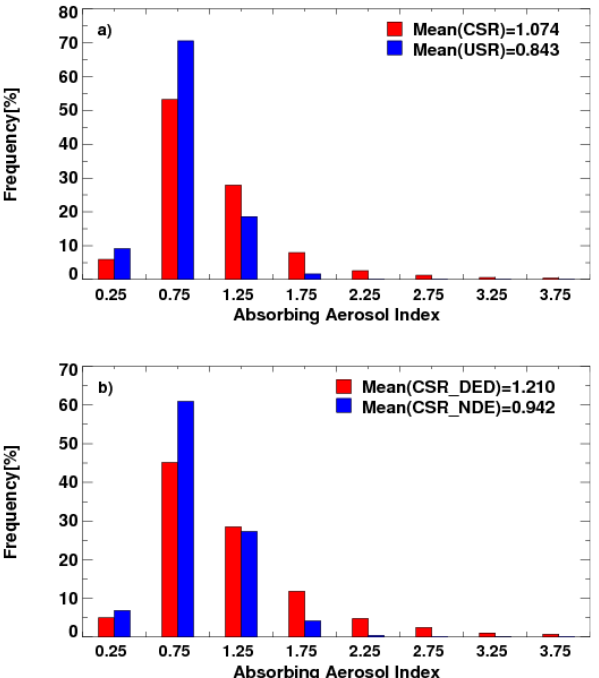
Fig. 6. Same as Fig. 5, but for absorbing aerosol index (AAI). The histogram intervals are 0.5.